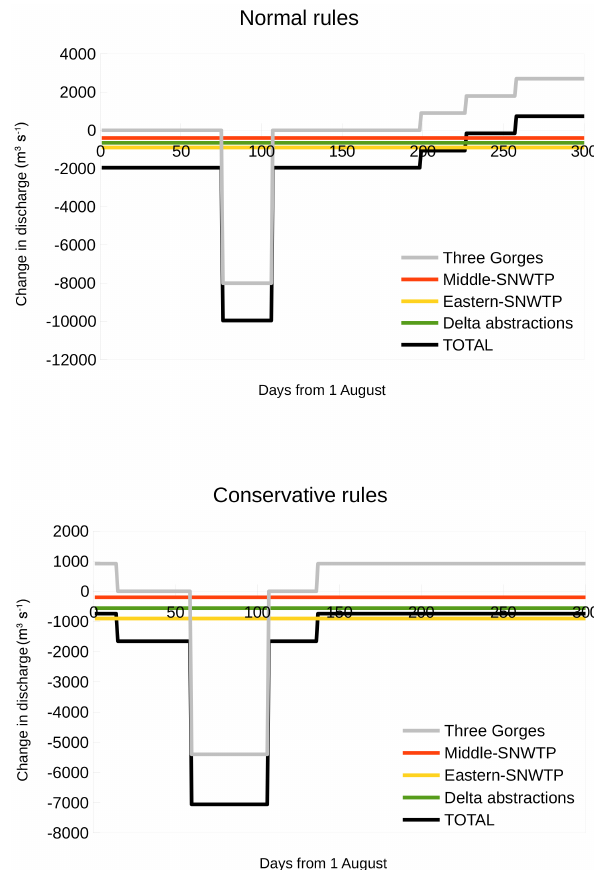
Figure 3. Change in discharge caused by normal and conserva- tive operating rules for Three Gorges Dam, the South–North Water Transfer Project and local